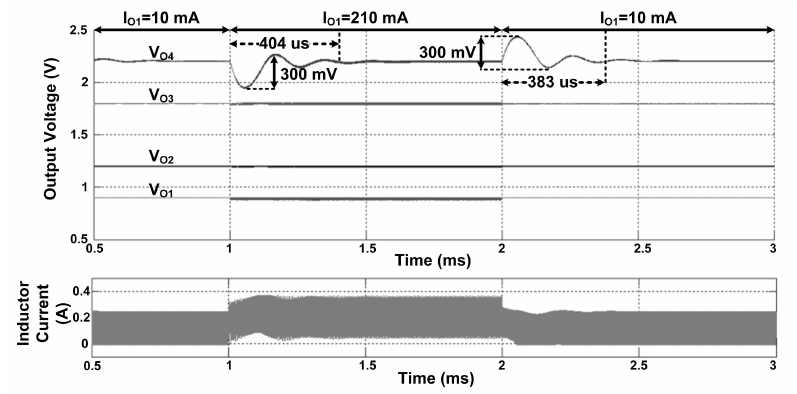
Figure 11. Simulation results at load transient of output one without the hybrid control technique.